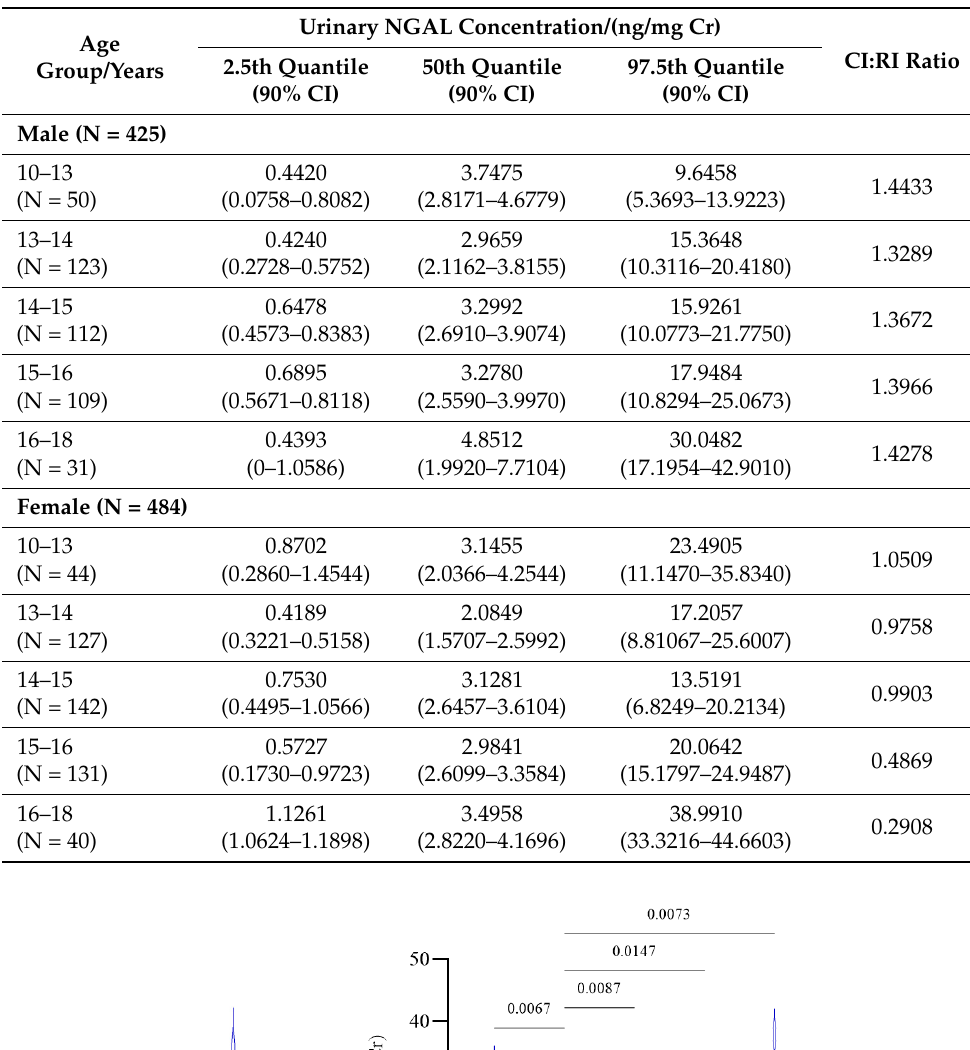
Table 2. The reference intervals (RI) and confidence intervals (CI) for creatinine-adjusted urinary NGAL levels for children. The ratio of the 90% confidence interval to the reference interval of the 97.5th quantile is given as the CI:RI ratio.